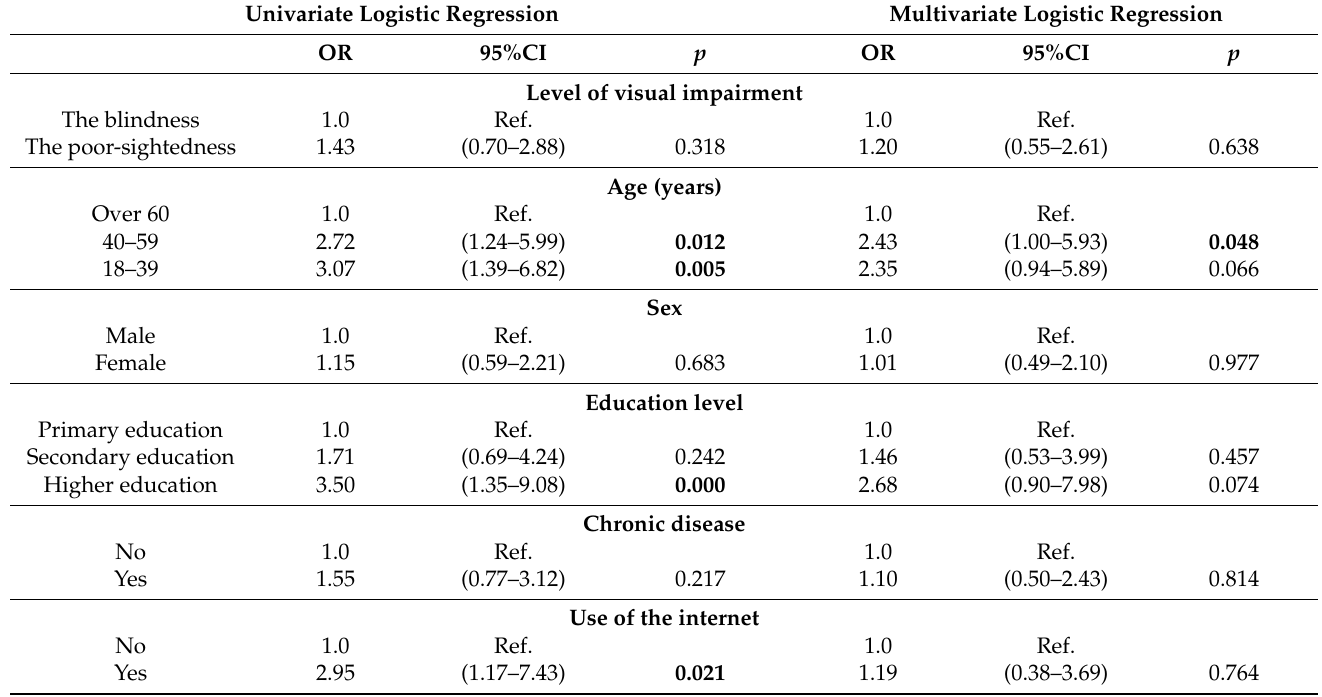
Table 2. Interest in TCs using in the total group—univariate and multivariate logistic regressions. Univariate Logistic